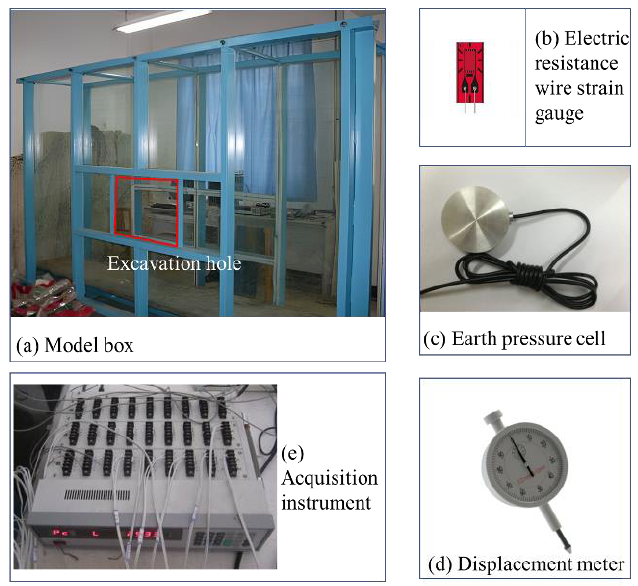
Figure 4. Test apparatus.